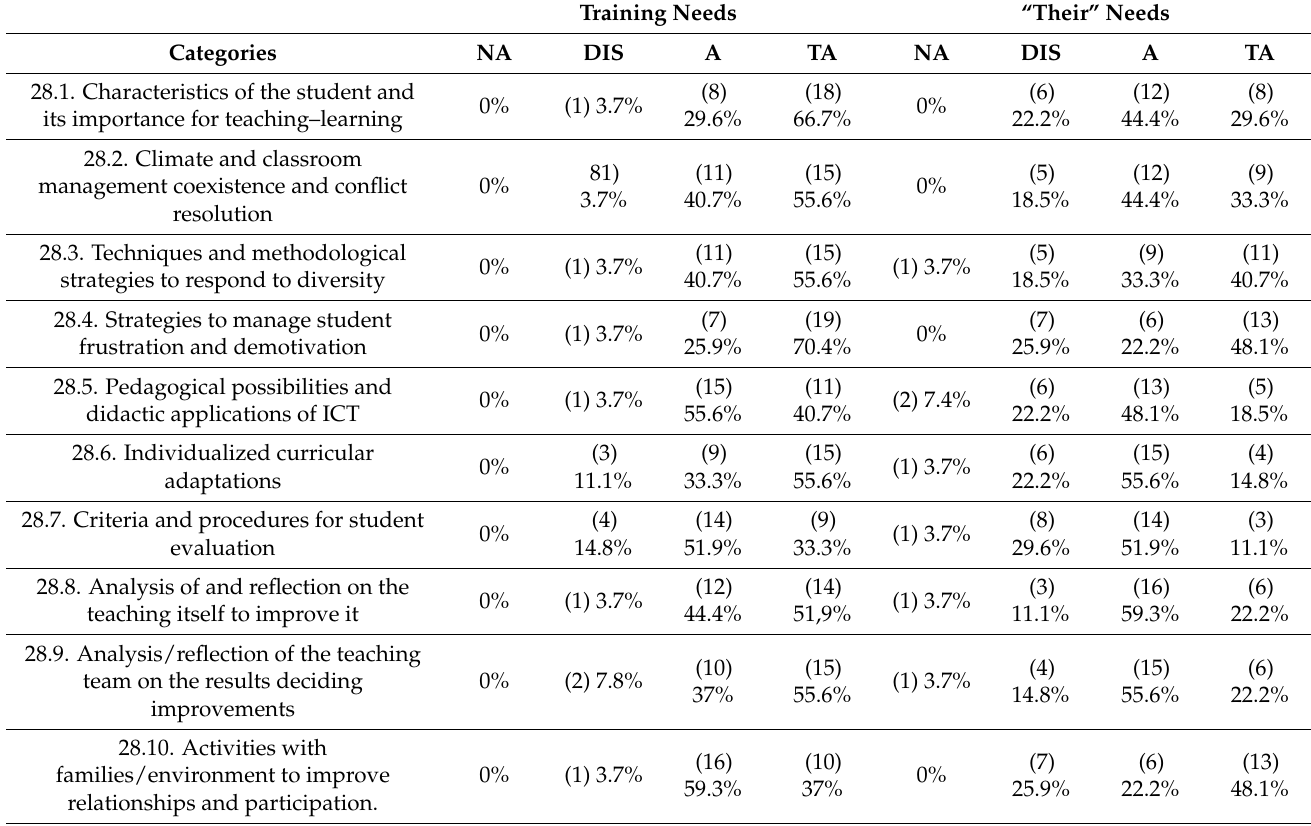
Table 4. Degree of agreement of the teaching staff on the training necessary to work with students